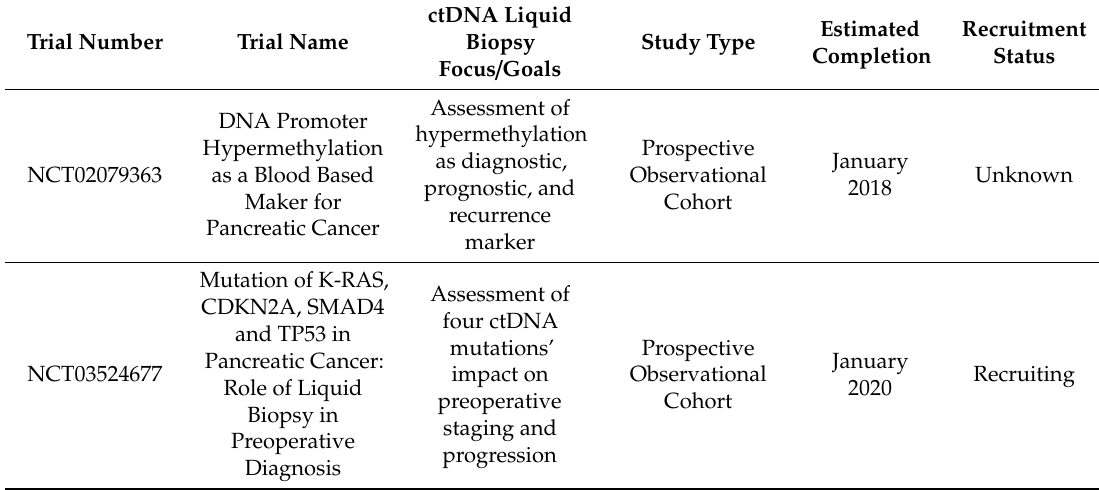
Table 1. Current trials registered with clinicaltrials.gov exploring liquid biopsy with cfDNA in pancreatic